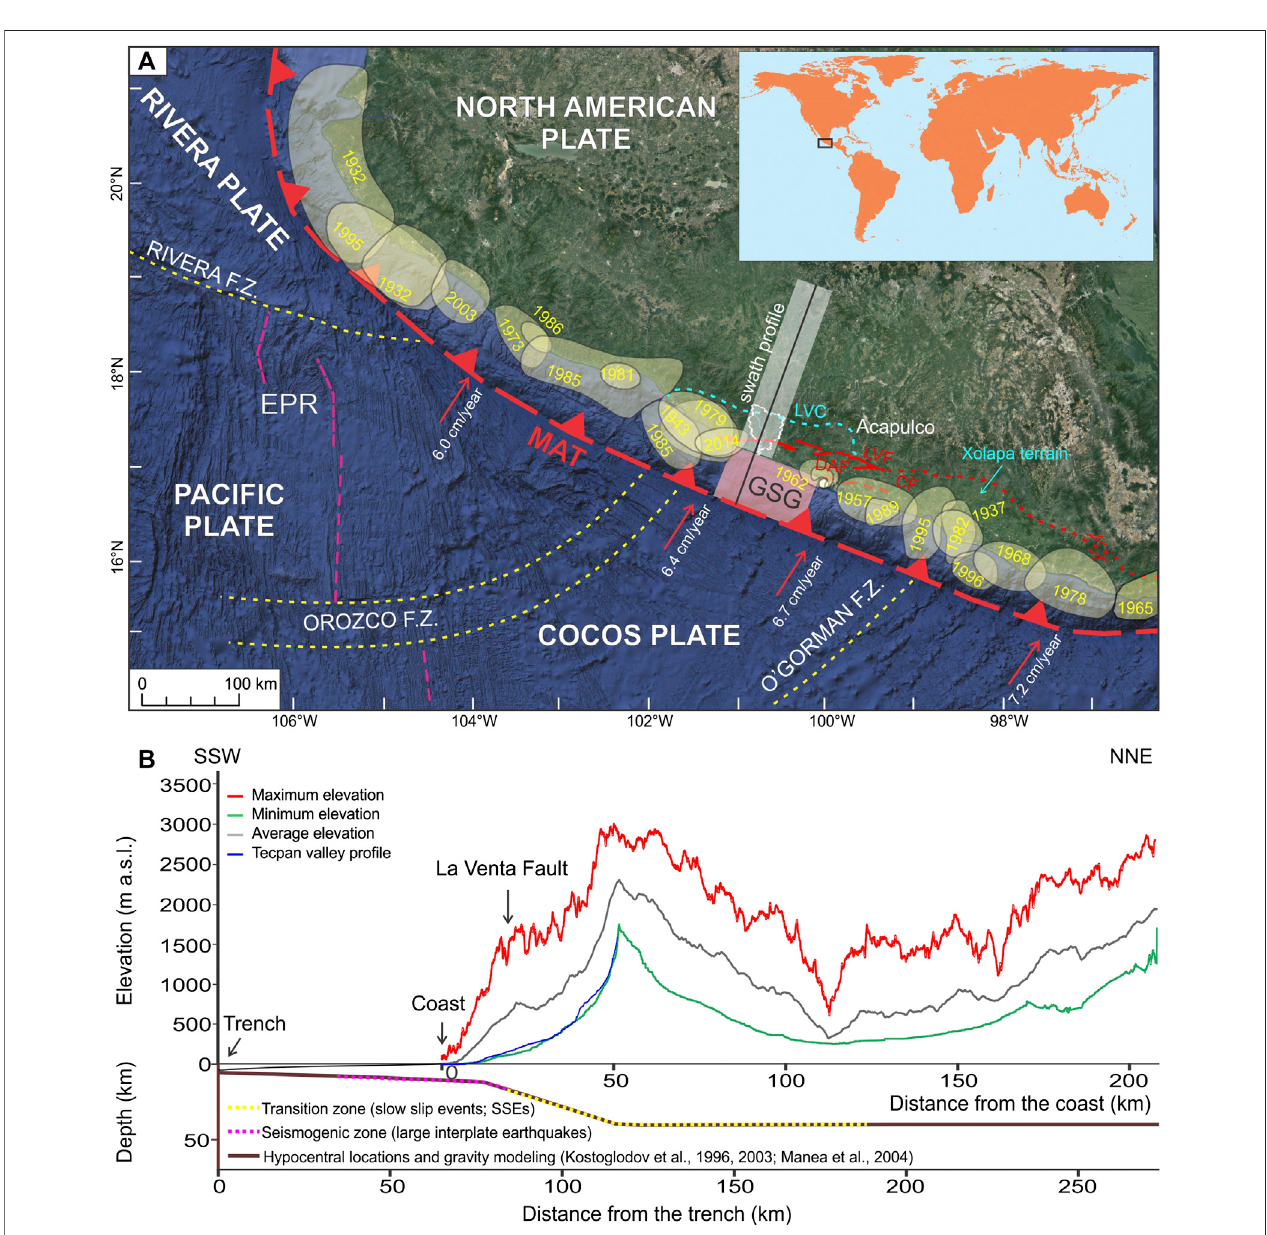
FIGURE 1 | (A) Tectonic setting of the Mexican subduction zone: MAT — Middle America Trench (red dashed line with barbs); F.Z. — fracture zone (yellow dashed lines); EPR — East Paci fi c Rise (pink dashed line); red arrows show convergence rate (DeMets et al., 2010); colored circles show rupture zones of the most important thrust events of 20th century; pink rectangle shows the Guerrero seismic gap (GSG); LVC — La Venta-Chacalapa Fault; CF — Cacahuatepec Fault; and DAF — Dos Arroyos Fault. The Xolapa terrain is the area between the MAT and the LVC. Red half-arrows show the sinistral motion of the Sliver fault. (B) Swath pro fi le and geometry of the subducting slab across a transect in the Guerrero